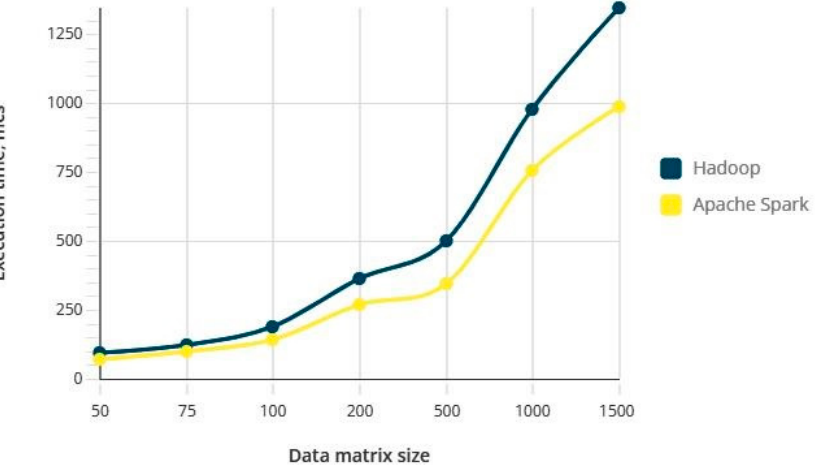
Figure 12. Computation speed comparison of Hadoop and Spark’s for Funk SVD calculation.